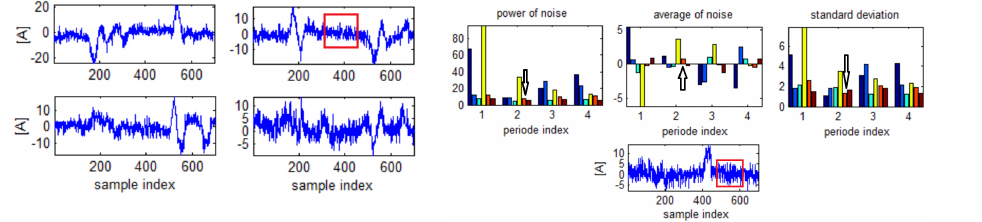
Figure 4. Top - example of metrics for a quasi- stationary subinterval. Bottom the corresponding es- timated